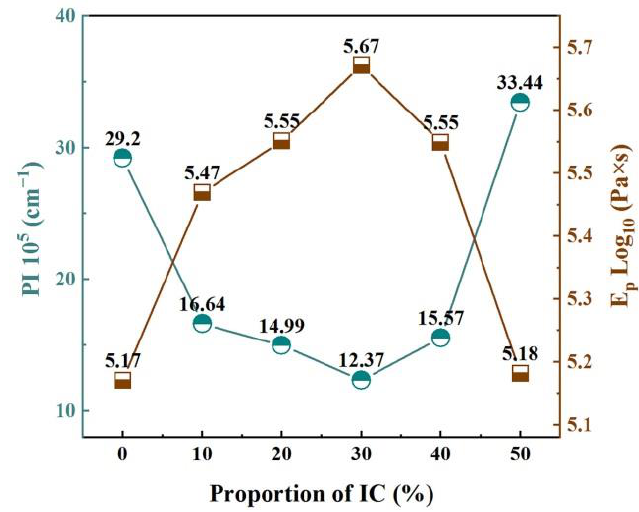
Figure 8. PI and E p of the ceramic samples.